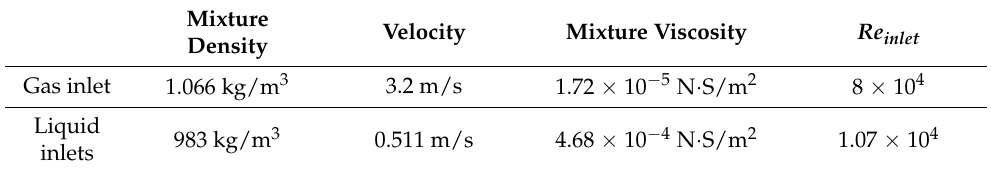
Mixture Density